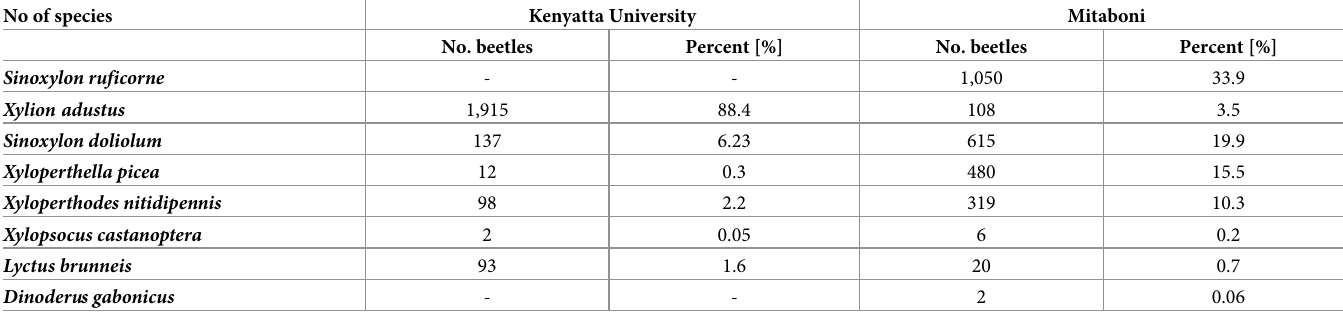
Table 4. Abundance of Bostrichidae species recorded from Acacia xanthophloea (cid:3) at Kenyatta University and Mitaboni from May 2016 –Feb 2017.